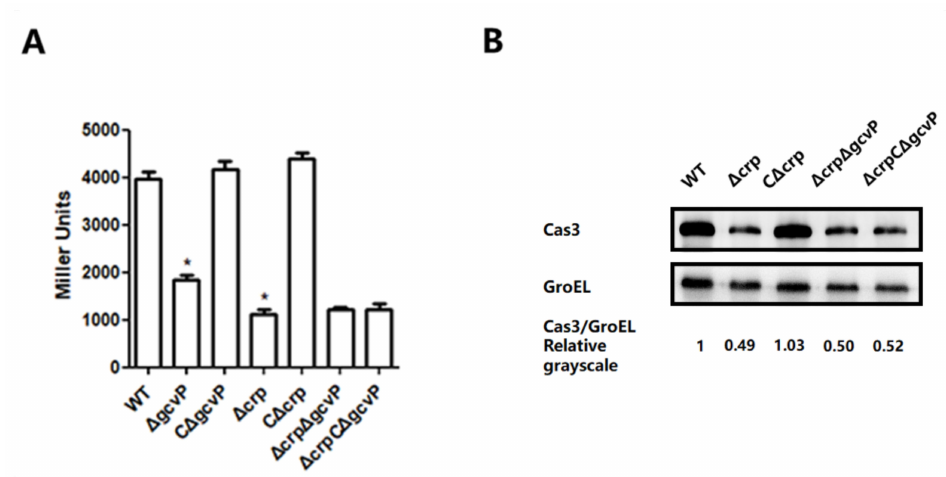
Figure 7. The e ff ect of glycine cleavage system (GCS) on cas3 expression is mediated by CRP. ( A ) The β -gal activity of the cas3 promoter was measured by reporter plasmids in WT, ∆ gcvP , C ∆ gcvp , ∆ crp , C ∆ crp (EC71), ∆ crp ∆ gcvP (EC81), or ∆ crp C ∆ gcvP (EC151). The cas3 expression of ∆ crp ∆ gcvP and ∆ crp C ∆ gcvP were significantly reduced. They were not any lower or higher than the ∆ crp . ( B ) The expression level of cas3 by Western blotting. The value was calculated from the relative grayscale value of cas3 to GroEL, and the value of WT was normalized as one. The result was consistent with β -gal assat. All the data were mean ± SEM of at least three replicates, and the p value (* p < 0.05) was analyzed by the t